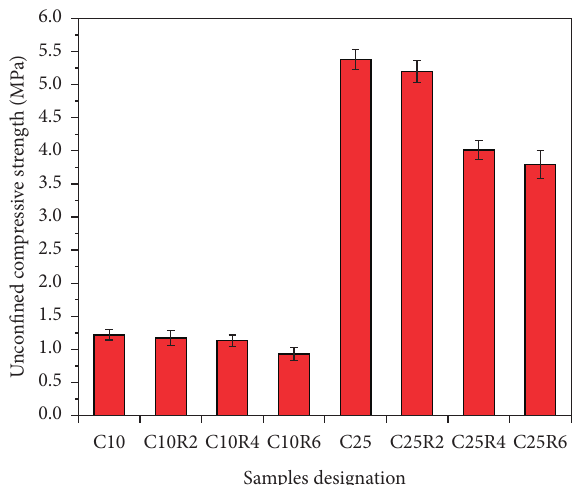
Figure 4: Unconfined compressive strength of cemented tailings